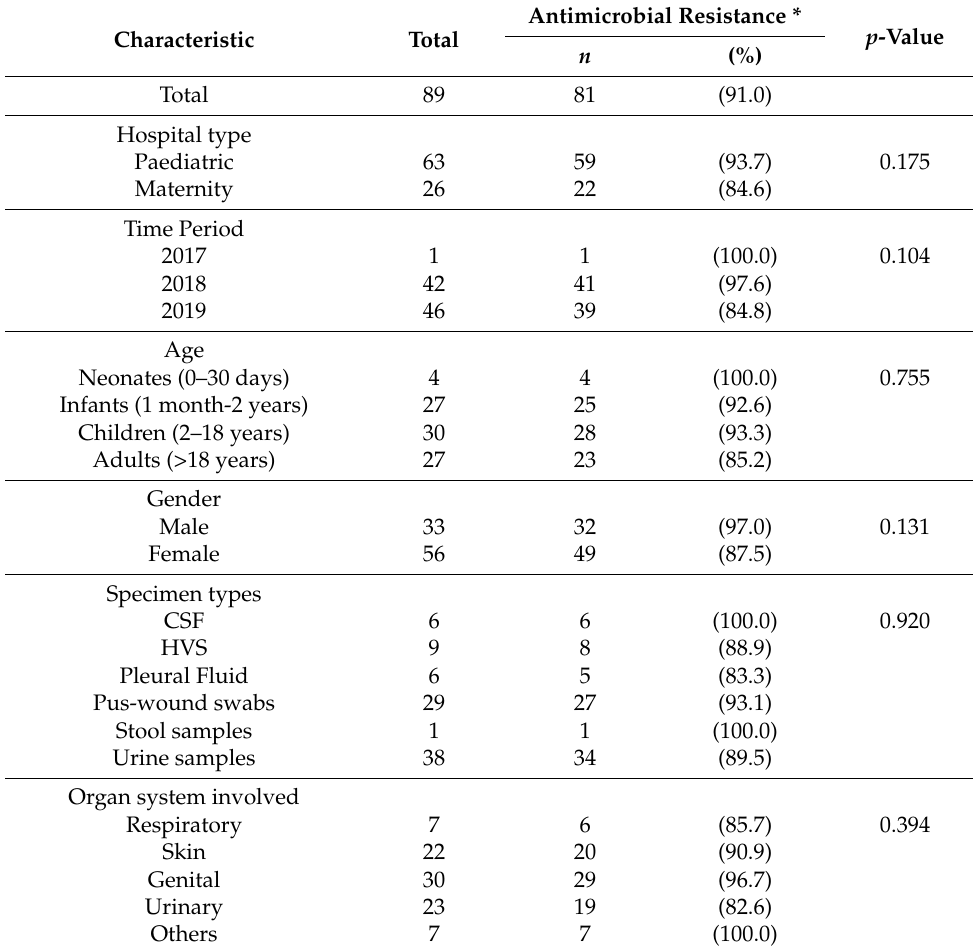
Table 2. Factors associated with antimicrobial resistance among cultures with bacterial growth from two referral hospitals in Freetown, Sierra Leone from 2017 to 2019.